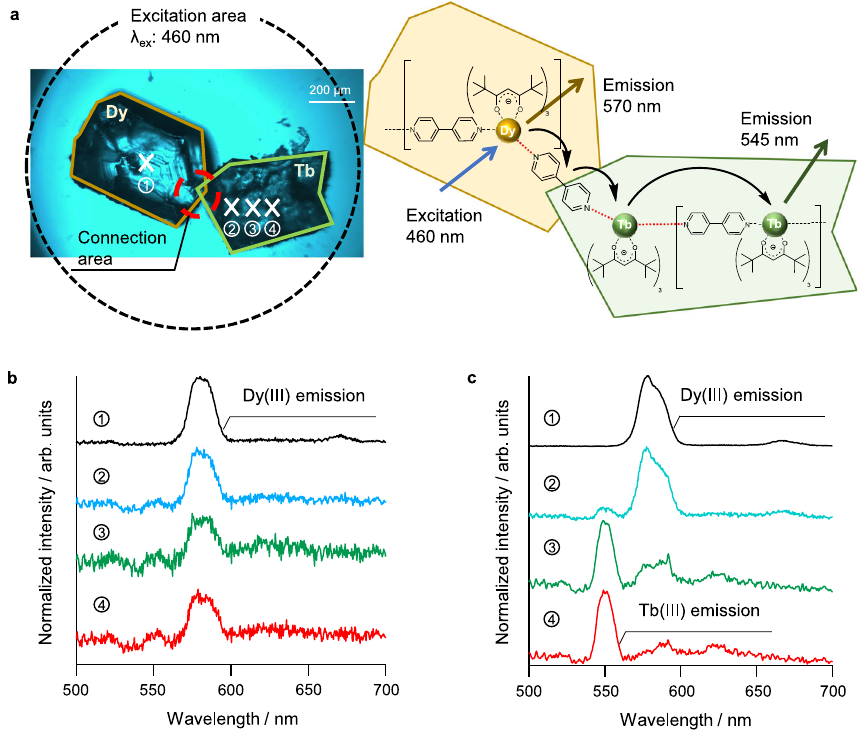
Fig. 4 Energy migration in a merged Dy(III) crystal-Tb(III) crystal. a Photophysical measurement schematic diagram. The crystal sample is excited using a 460 nm light source for direct Dy(III) excitation. Emission spectra were measured by spatially resolved microspectroscopy and normalized at their peak top. Position-dependent emission spectra in position 1 (black line), position 2 (blue line), position 3 (green line) and position 4 (red line) of the b dinuclear system (before transformation), and c coordination polymer (after transformation). Dy, dysprosium; Tb, terbium.